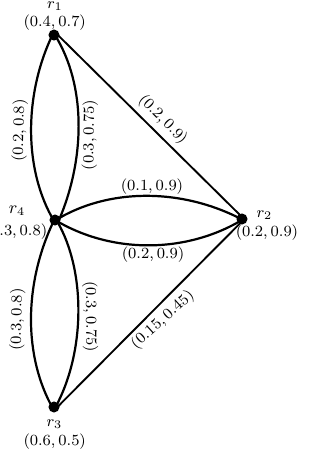
Figure 2.1: Pythagorean fuzzy multigraph Figure 2. Pythagorean fuzzy